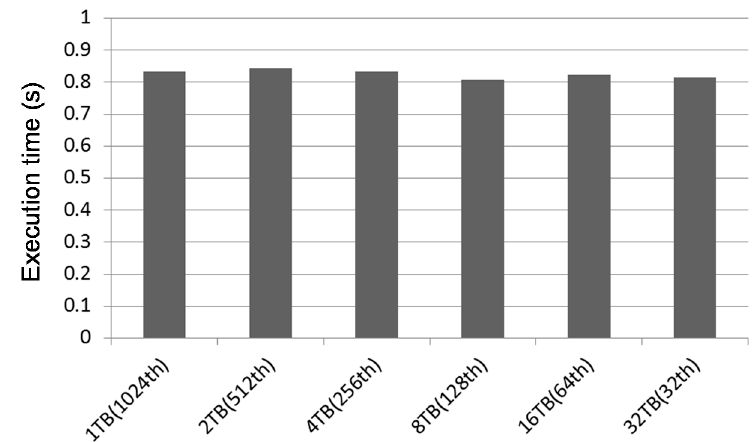
Figure 3. Execution time as the thread block size is varied with the same number of total threads; 1